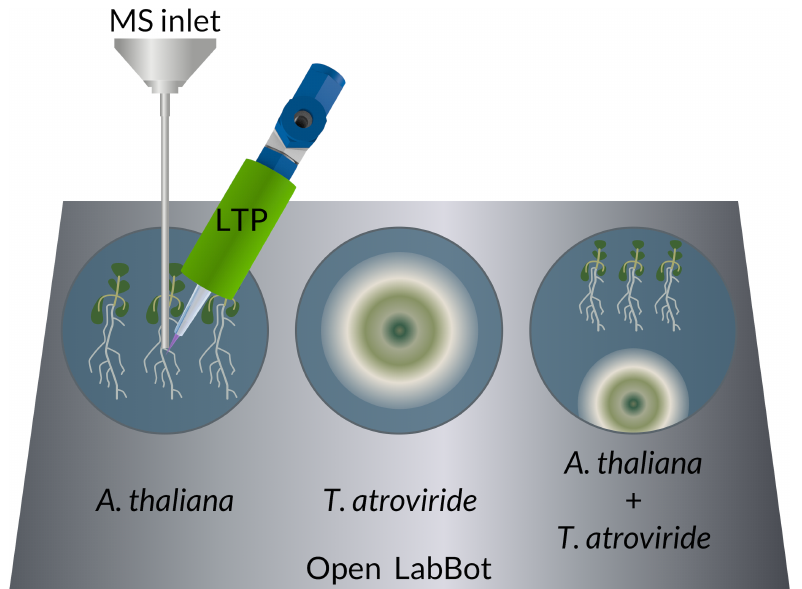
Figure 1. Experimental set-up for studying the plant-fungal interaction between Arabidopsis thaliana and Trichoderma atroviride in vivo with low-temperature (LTP) ionization mass spectrometry